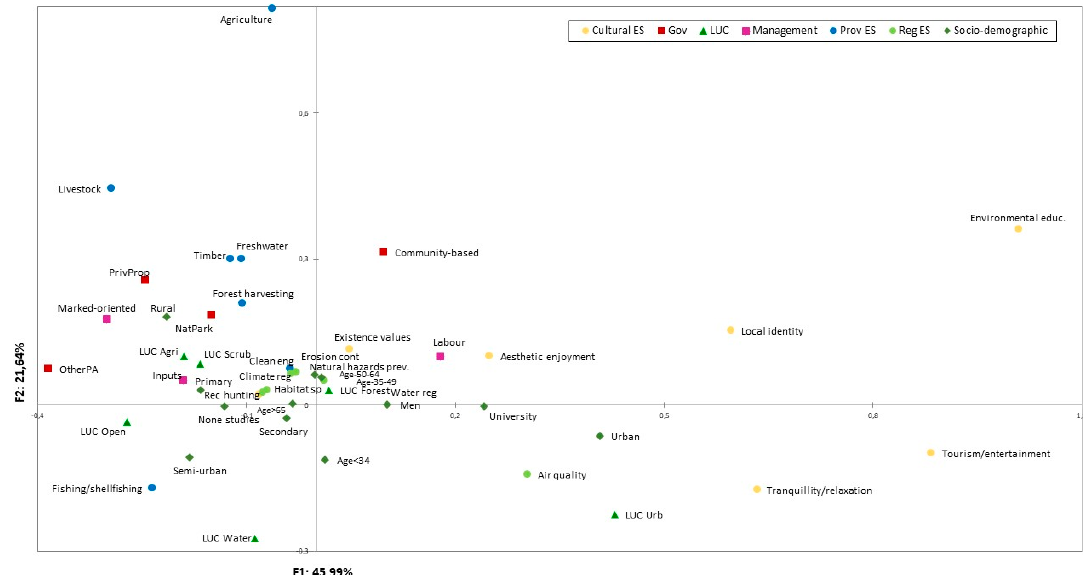
Figure 4. Redundancy analysis (RDA) biplot showing the relationships between social perceptions towards ecosystem services (ES) and variables related to biophysical, socio-demographic and institutional factors.